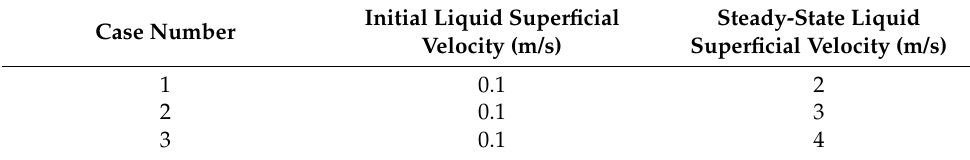
Table 2. Liquid superficial velocity